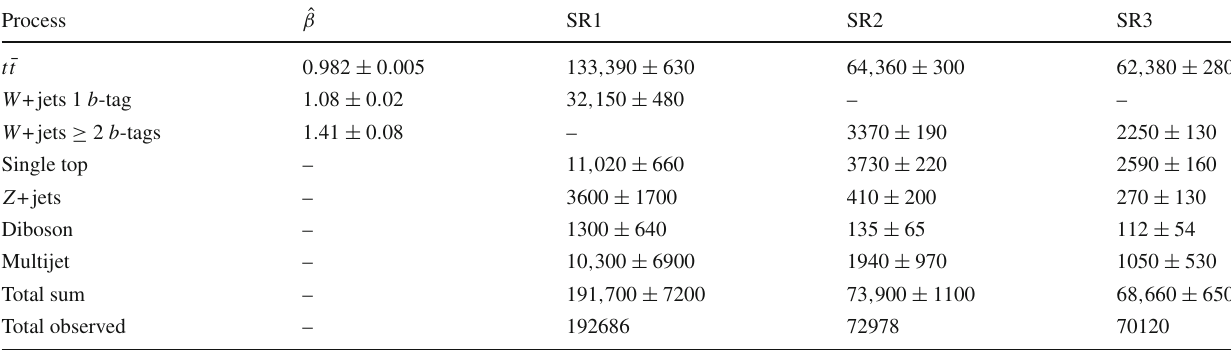
Table 3 Result of the maximum-likelihood fit to data. Estimators of the parameters of the likelihood function, the scale factor ˆ β for the t ¯ t and the two W +jets channels and the derived contributions of the vari- ous processes to the three signal regions are listed. Only the statistical